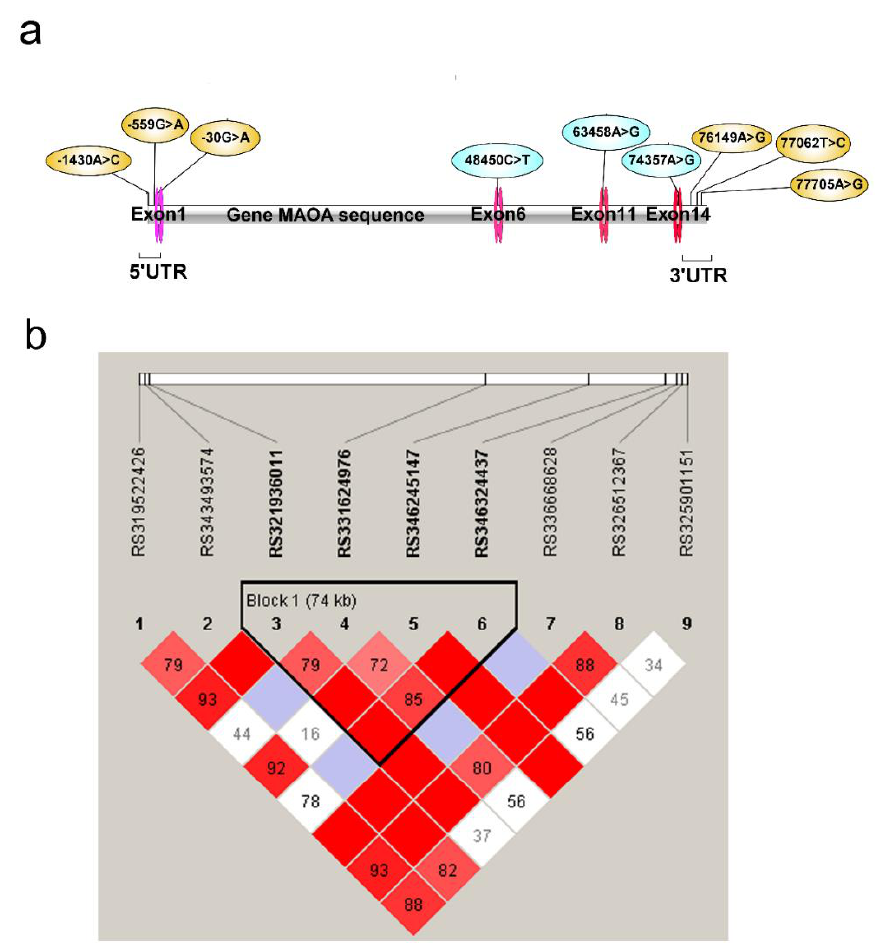
Figure 3. The linkage disequilibrium analysis of nine SNPs in the MAOA gene. ( a ) The position of nine SNPs in pig MAOA gene. ( b ) Linkage disequilibrium analysis of the nine potential SNPs. Four (rs321936011, rs331624976, rs346245147, and rs346324437) of nine potential SNPs showed linkage inheritance resulting in five haplotypes (GCAA, ACGA, GCGA, ATGG, and ACGG/GTAA).